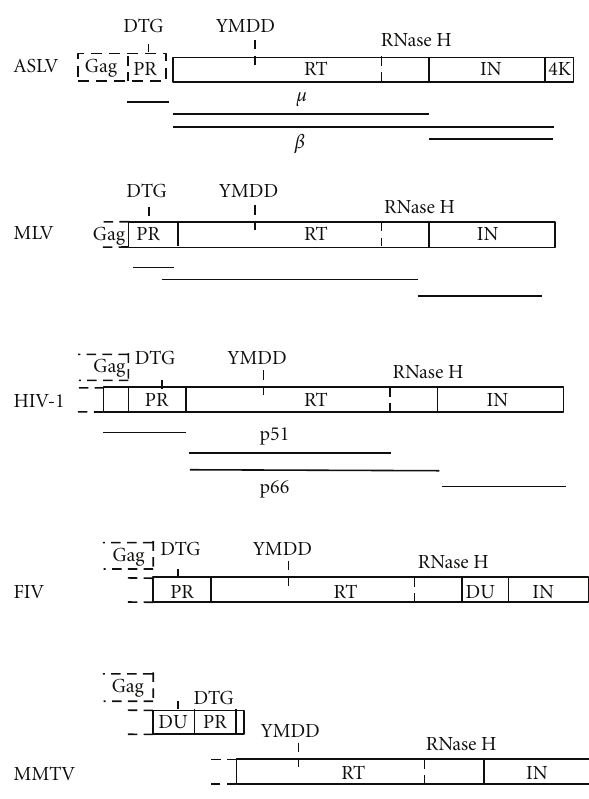
Figure 2: Organization of Pro and Pol proteins. Schematic representations of the mature Pro and Pol proteins and their precursors are drawn for examples from several retroviruses. The sequences representing the mature proteins PR, RT, and IN are indicated. Rectangles, precursor proteins, with solid vertical lines marking major cleavage sites and thick horizontal bars indicating mature proteins. DTG or DSG and YMDD indicate the conserved active site residues in PR and RT. The RNase H domain of RT is also indicated (ASLV: avian sarcoma leucosis virus, MMTV:murine mammary tumor virus, MLV: murine leukemia virus, and FIV: feline immunodeficiency